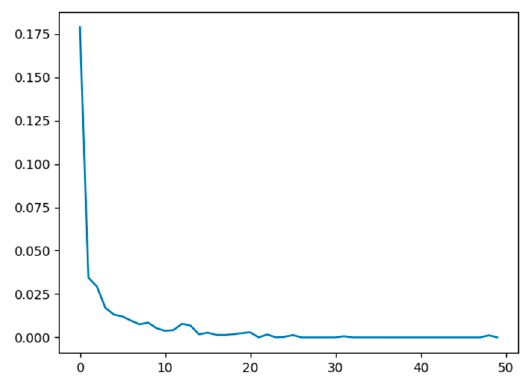
Figure 11. Model loss versus number of epochs (50) by training on LivDet 2015 dataset.